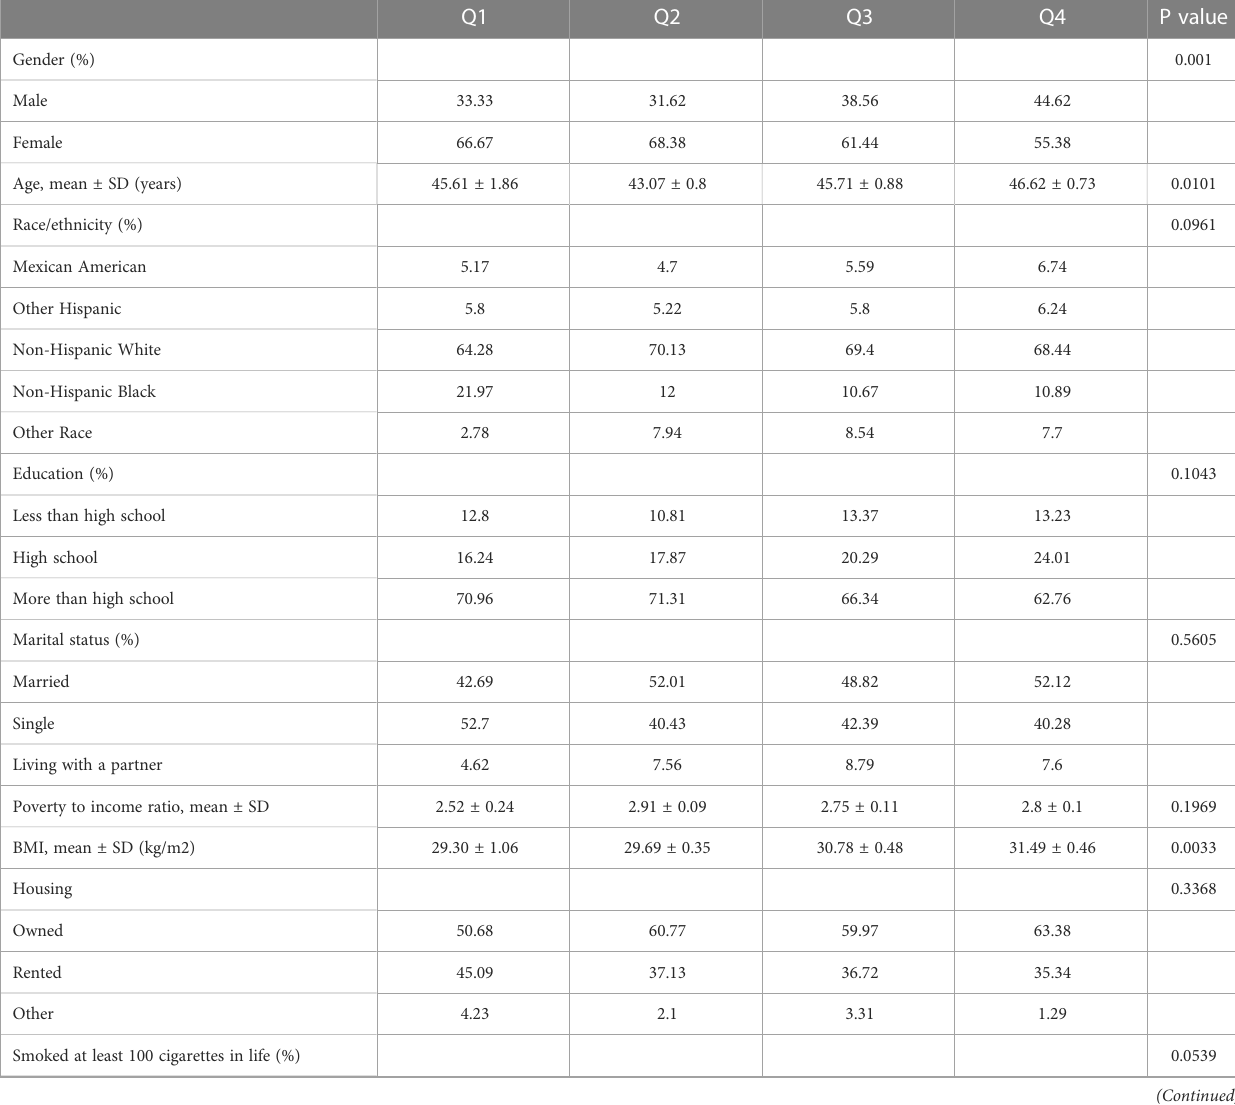
TABLE 1 Weighted basic characteristics of the analyzed population based on the quartiles of blood eosinophils